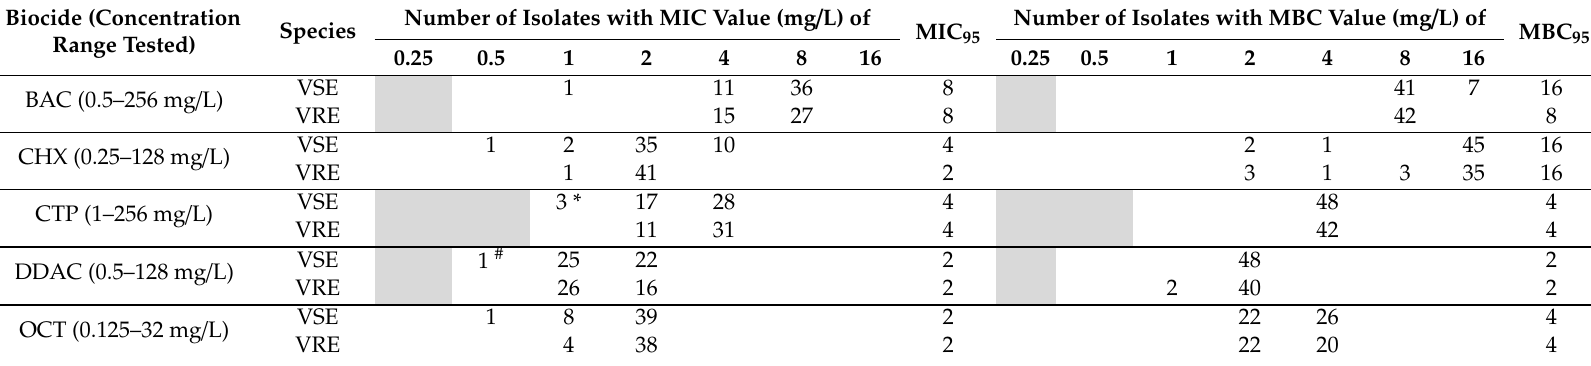
Biocide concentrations which have not been tested are shaded in gray. BAC = benzalkonium chloride, CHX = chlorhexidine dihydrochloride, CTP = cetylpyridinium chloride, DDAC = didecyldimethylammonium chloride, OCT = octenidine dihydrochloride, VRE = vancomycin resistant Enterococcus faecium , VSE = vancomycin susceptible Enterococcus faecium , # MIC ≤ 0.5, * MIC ≤